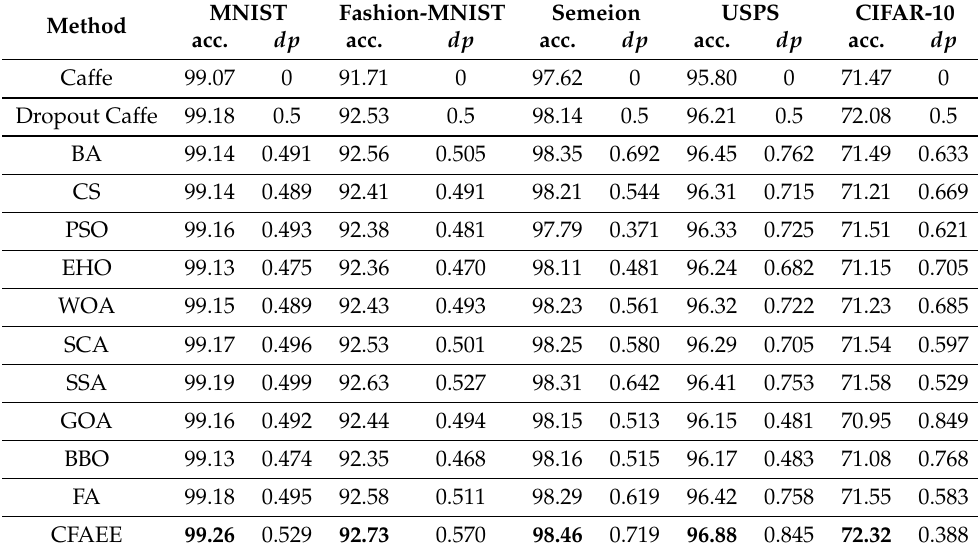
Table 18. Comparative results between the proposed CFAEE and other metaheuristics in terms of mean classification